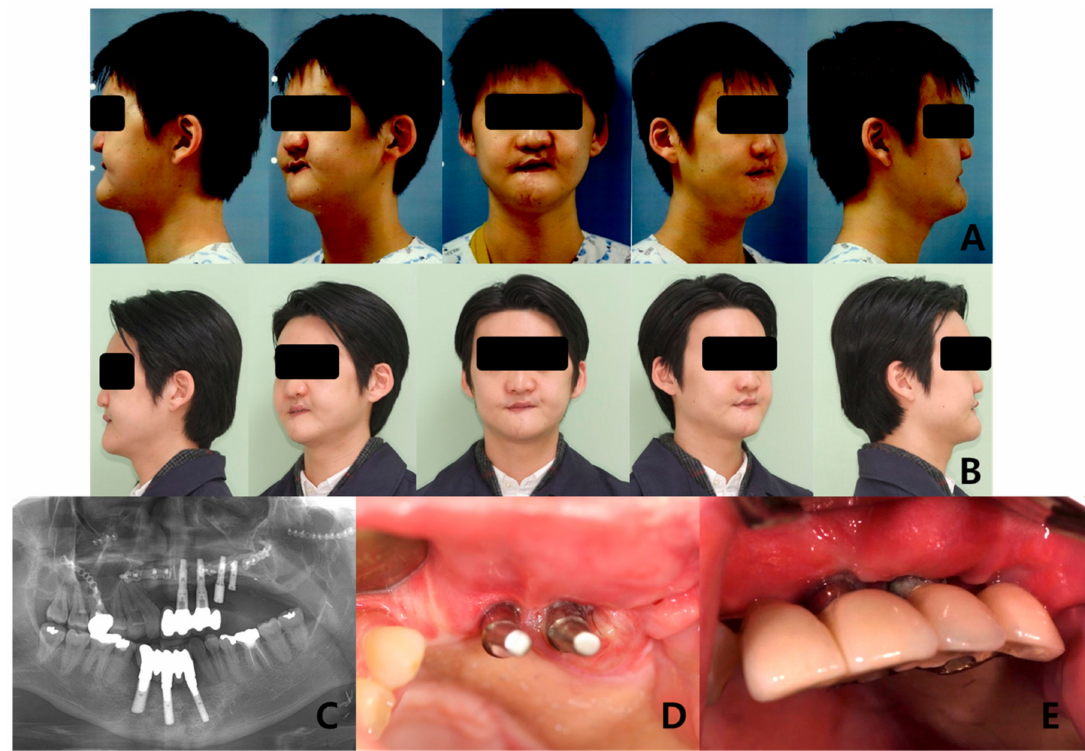
Figure 4. Long-term follow-up of the patients who received prosthetic rehabilitation with dental implant after the fibula free flap: ( A ) Preoperative clinical photos, ( B ) postoperative clinical photos after 4 years, ( C ) panoramic radiograph after implant treatment, ( D ) connection of the customized abutment, and ( E ) final